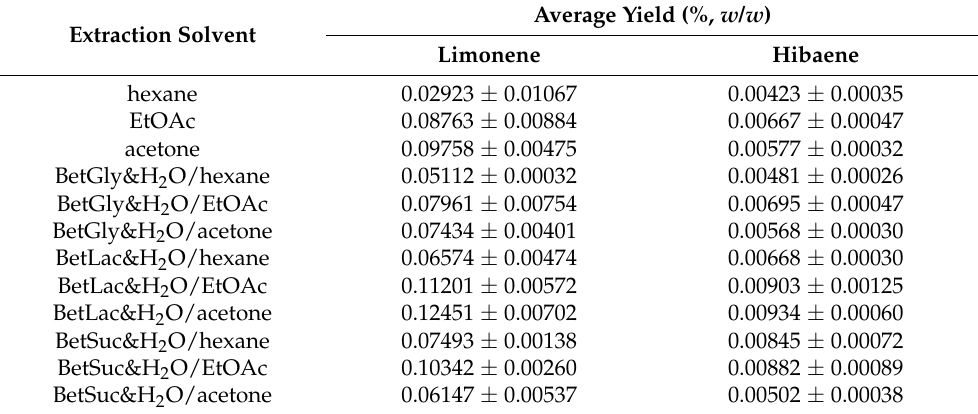
Table 2. Extraction yields for limonene and hibaene ( n =